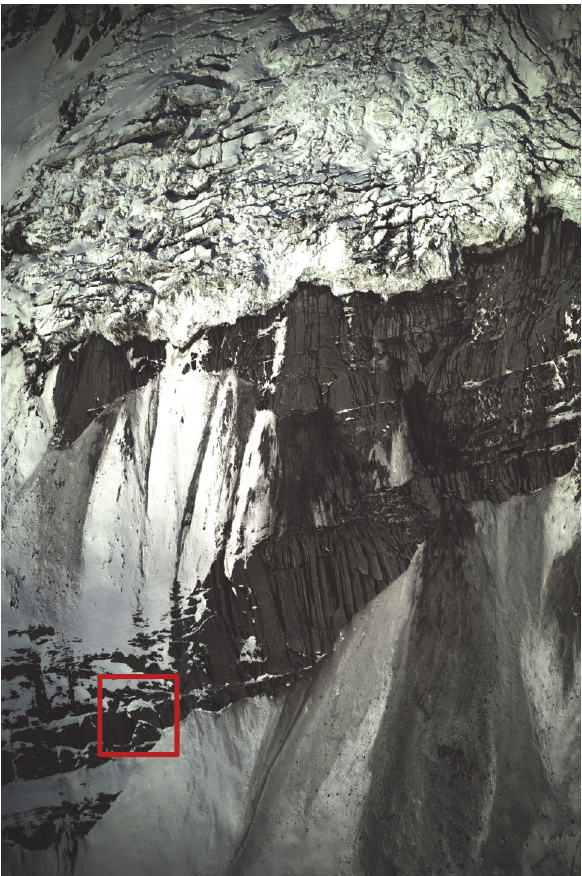
Figure 7. Single image of a steep slope and icefields in the Upper Seti Valley. Position at the time of exposure was 28.549747°N/84.039636°E/5,700 m altitude with an off-nadir angle of 73.8°. The red rectangle indicates the extent of Figure 8